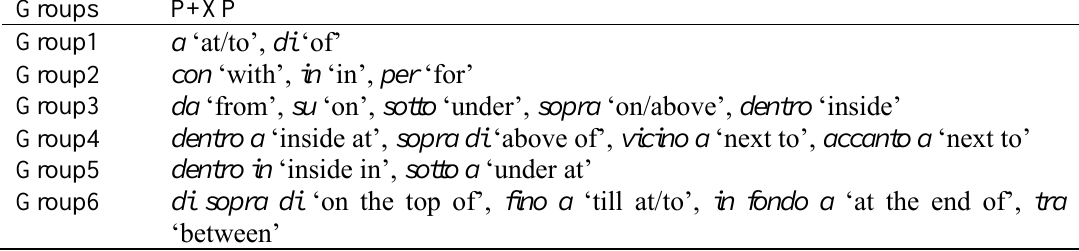
Table 7. First appearance of prepositions in the P+XP context across MLU Groups